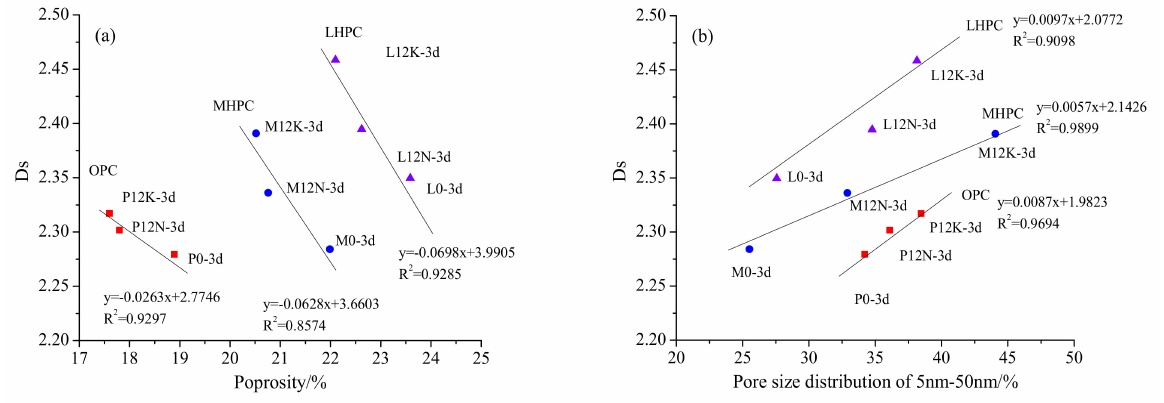
Figure 12. Relationship between pore structure and D s of mortars with different alkali sulfates contents. ( a ) Porosity; ( b ) pore size distribution of 5–50